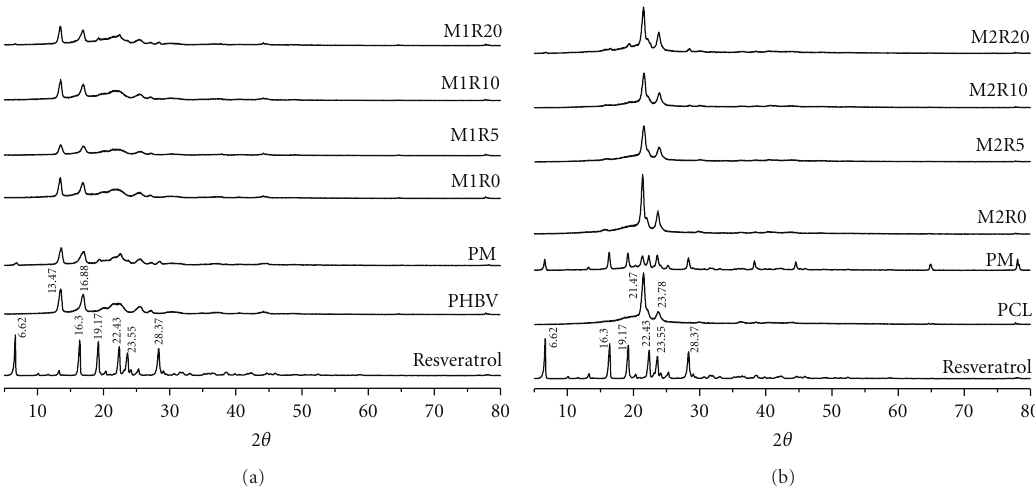
Figure 4: XRPD patterns of resveratrol, PHBV/PCL, physical mixtures, and PHBV/PCL microparticles.